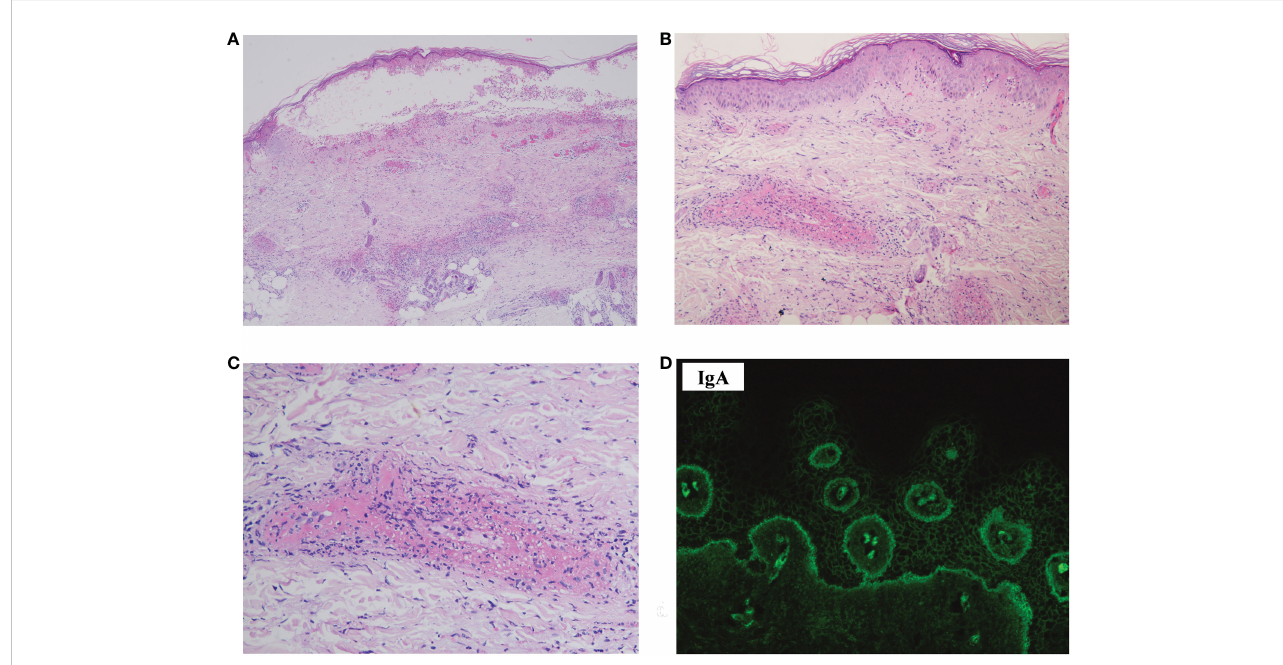
FIGURE 2 Histopathology, DIF, and immunohistopathology of the skin biopsy sample. (A) Hematoxylin – eosin staining showed a subepidermal blister, with perivascular in fi ltration of in fl ammatory cells in the dermis (×40). (B) Leukocytoclastic vasculitis affecting small-to-medium-sized vessels were observed in the dermis (×100). (C) Leukocytoclasis forming nuclear dust and fi brinoid necrosis of the vessels (×200). (D) DIF revealed deposits of IgA in the intercellular space of the epidermis and BMZ (×400). DIF, direct immuno fl